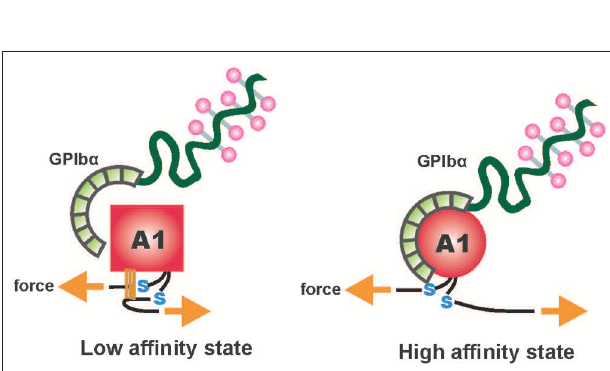
FIGURE 3 | A two-state model depicting flow-induced activation of the A1 domain of VWF, tethered to the vessel wall. Hydrogen bonds between residues, internal and external to the A1 disulfide link are disrupted due to mechanical tension under shear flow. This results in conversion of the A1 domain from a low-affinity, flexed state to a high-affinity extended state. Adapted and modified from Fu et al.